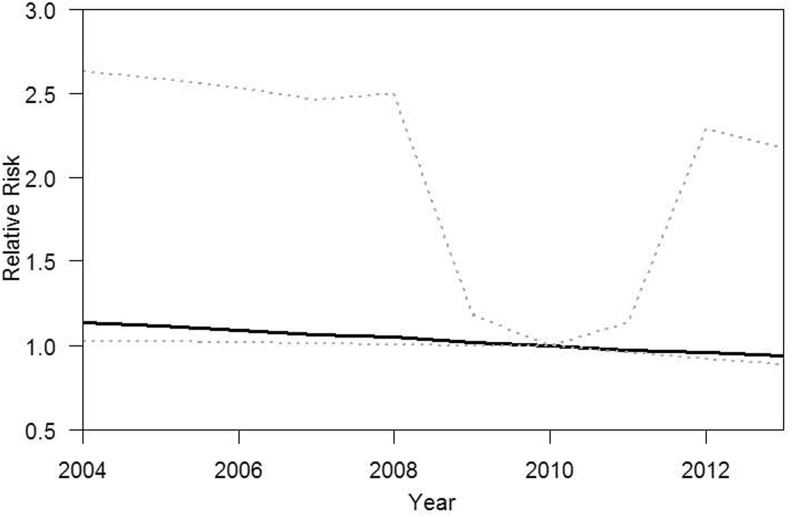
Non-linear effects of year estimated using second order random walk.